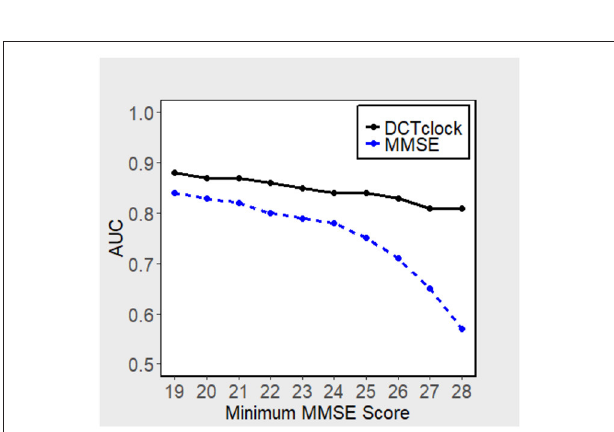
FIGURE 3 | AUCs of DCTclock and MMSE, subset using minimum MMSE score.